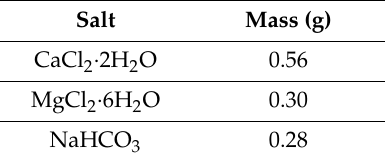
Table 2. The salts and amount in grams used to make 2 litres 15dH hard